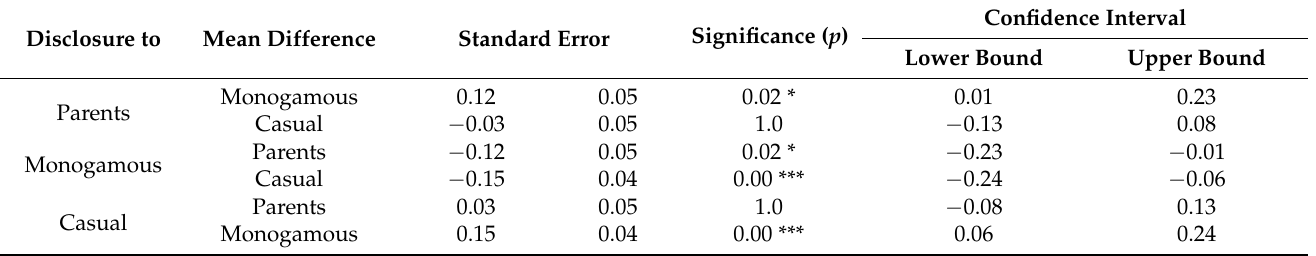
Table 2. Pairwise Comparisons of Shame and Stigma of Disclosure—One-Way Repeated-Measures ANOVA. Disclosure to Mean Difference Standard Error Significance ( p )